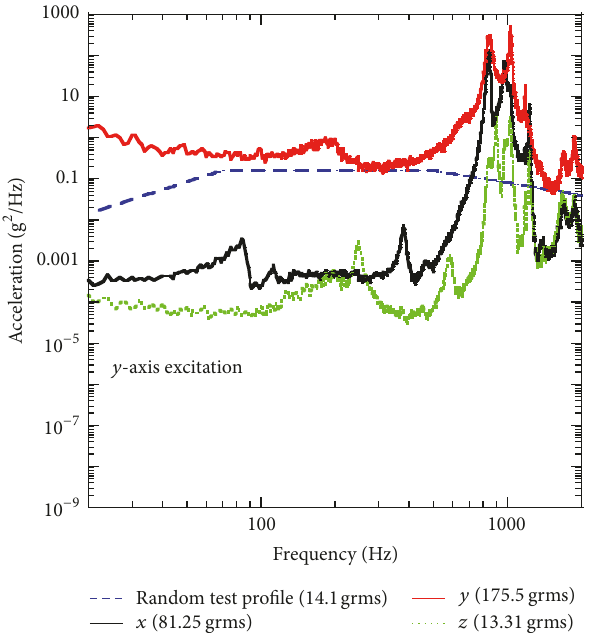
Figure 11: Representative results for random vibration tests of the RWA without isolation system when the 𝑦 -axis excitation was